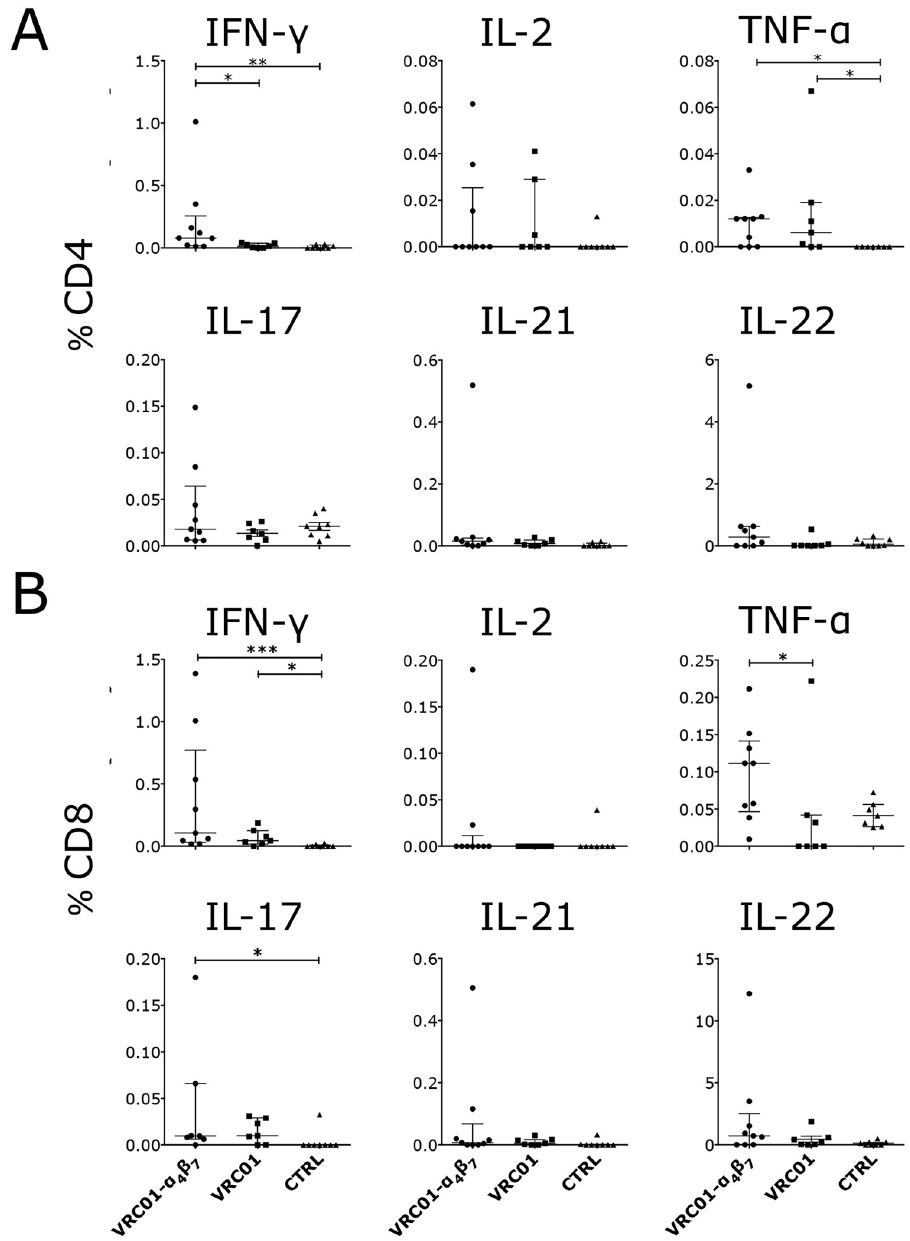
Fig 5. T cell responses to the SHIV AD8-EO V2-loop peptides are higher in Rh- α 4 β 7 -VRC01 treated macaques. A-B) PBMCs isolated around 18 weeks post infection were stimulated with a pool of 7 20mers with 14aa overlap peptides spanning the V2 loop of the SHIV AD8-EO envelope for 5 hours. The frequency of cells secreting the indicated cytokines are shown for the CD4 + (A) and CD8 + (B) T cell subsets after subtraction of the baseline values (in absence of peptides). The results of the Dunn’s multiple comparisons post-hoc test (after the Kruskal-Wallis test controlled for multiple comparisons) and the Mann-Whitney test to compare the treatment groups between each other are shown ( p - value of � α < 0.05, �� α < 0.01 and ��� α < 0.001 were considered significant). Bars represent median ± IQR. Note: ROUT (Q = 1%) analysis for outliers excludes the highest % of CD4 + and CD8 + T cells producing TNF- α in the VRC01 group. In the cleaned data set, the differences between the VRC01-only group and the control group in the CD4 + T cell subset is not significant and the difference between the VRC01- α 4 β 7 group and the VRC01 group in the CD8 + T cell subset becomes highly significant. There are no other changes due to outliers